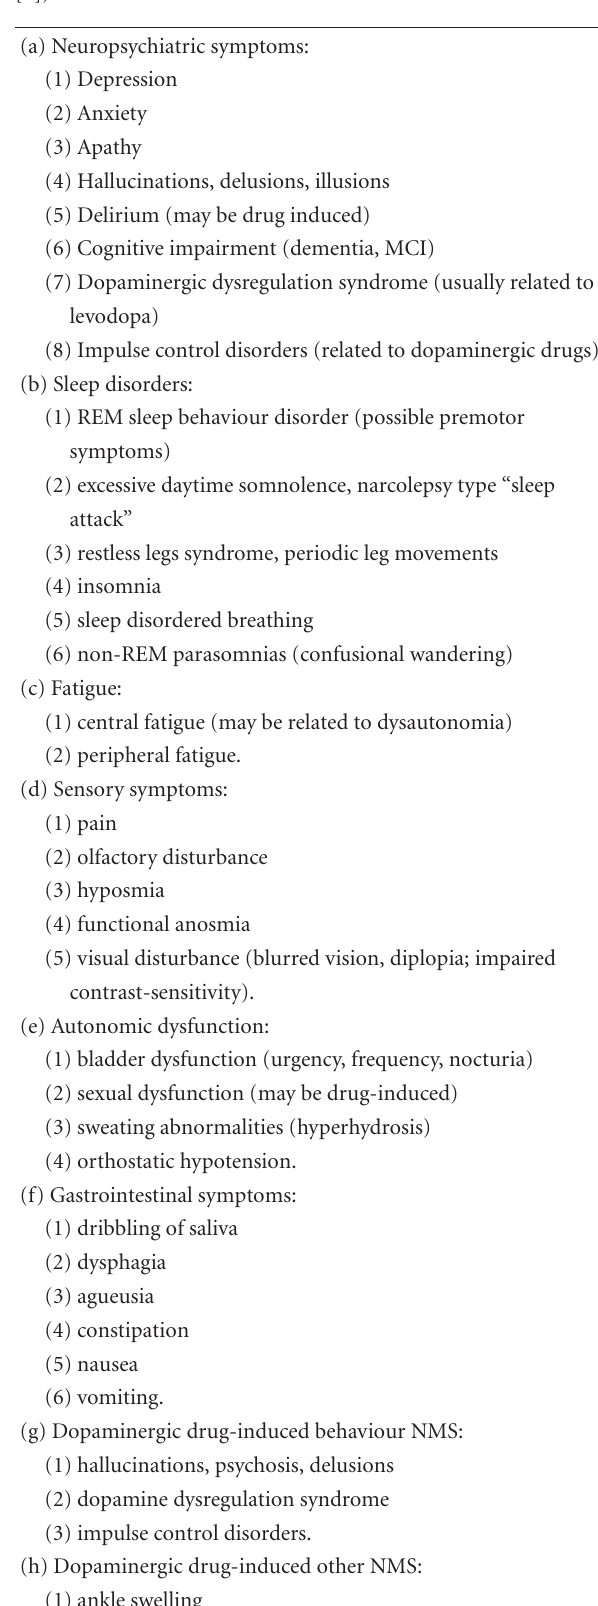
Table 1: Major nonmotor symptoms (NMS) in PD (adapted from [3])